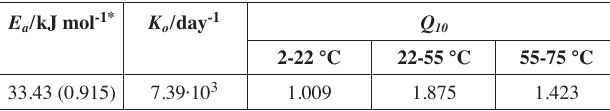
Tab. 2: Q 10 and E a values of polyphenols’ degradation at different storage